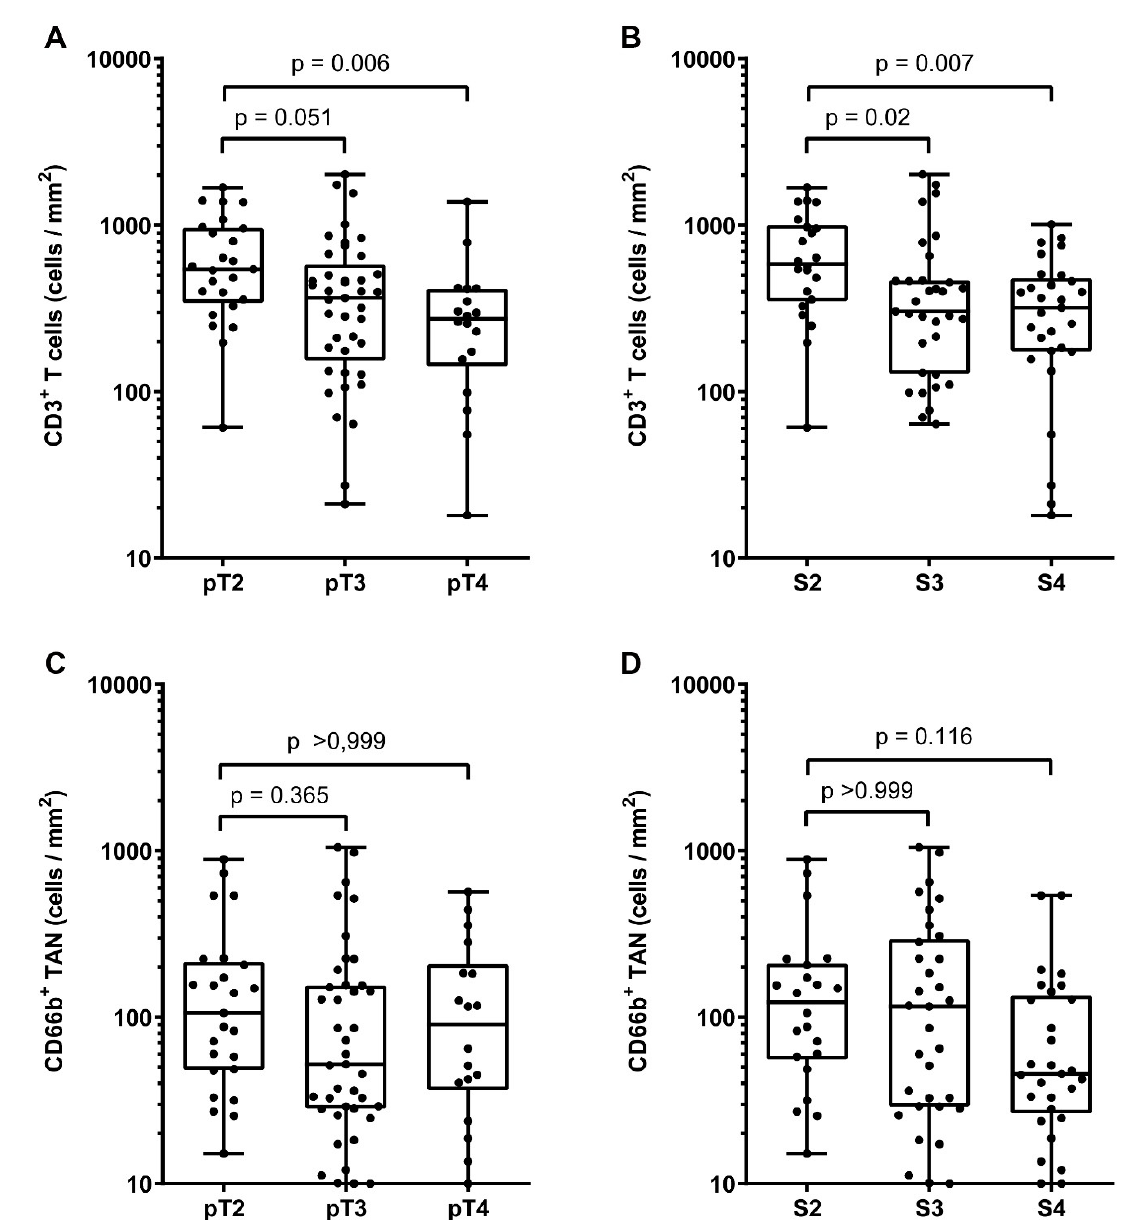
Figure 3. Clinical correlation of CD66b + TAN and CD3 + T cells densities in human MIBC. Dot plots showing CD3 + T cells ( A , B ) and CD66b + TAN ( C , D ) density distributions among different pT categories and Overall Stages in the MIBC cohort. p values were estimated by Kruskal-Wallis test and adjusted for multiple pairwise comparisons by Dunn’s method.